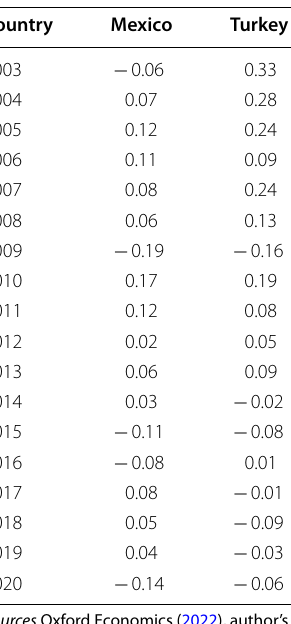
Table 5 GDP in current prices (annual changes), %